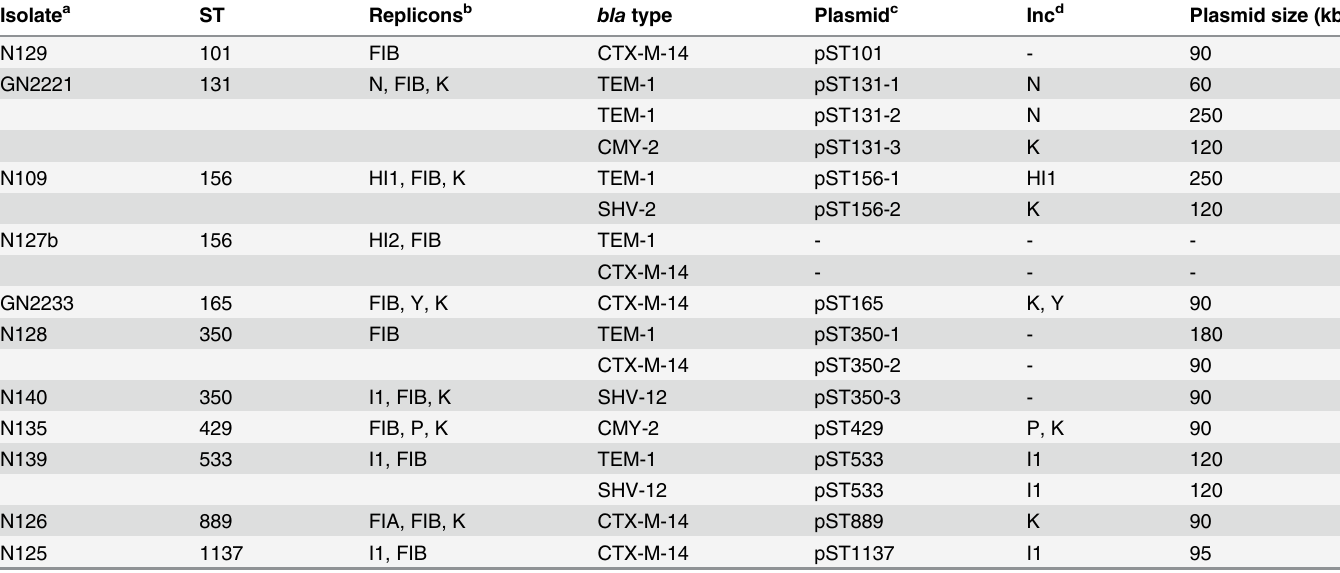
Table 3. Identification and characterisation of the location of bla CTX-M-14 , bla SHV-2 , bla SHV-12 , bla CMY-2 and bla TEM among 11 cephalosporin resistant E . coli isolates. Isolate a